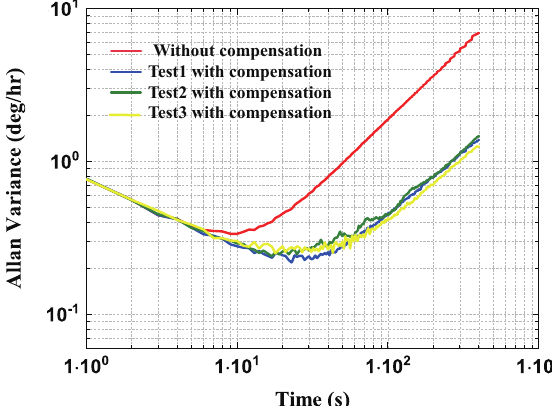
Figure 17. The Allan variance curve of ZRO before and after